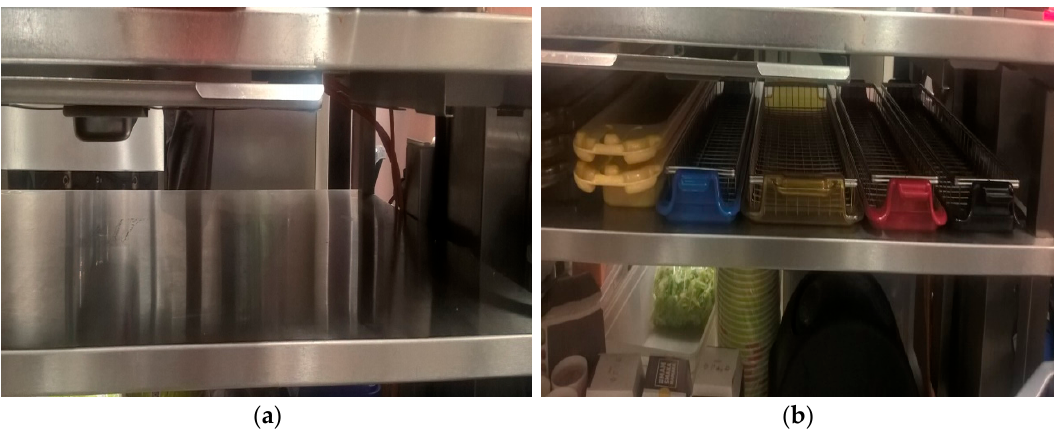
Figure 7. Management of unused space. ( a ) Free space designated for storage; ( b ) space managed upon applying the 5S method.